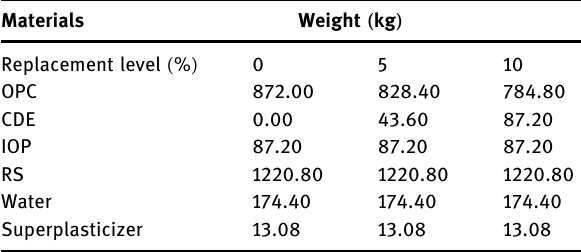
Table 3: Mix proportion for 1 m 3 concrete